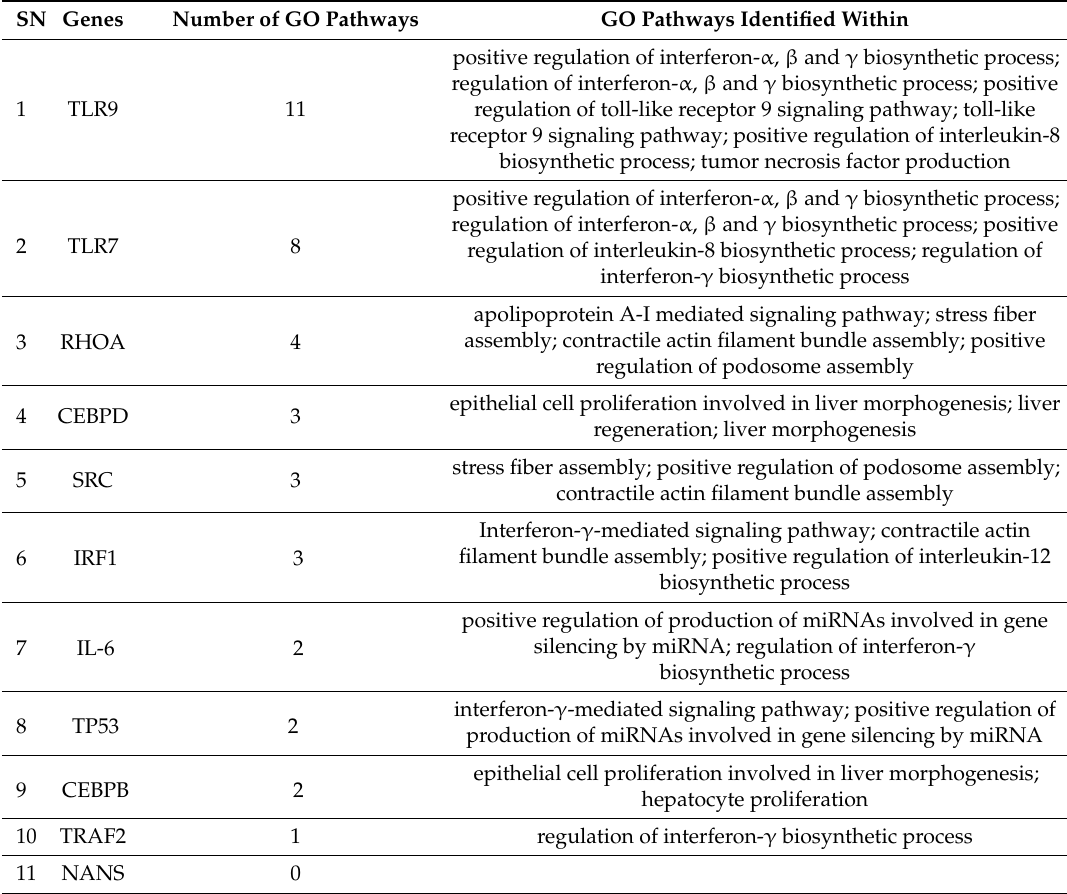
Table 1. List of significant genes in BCoV infection and the number of significant pathways they appeared